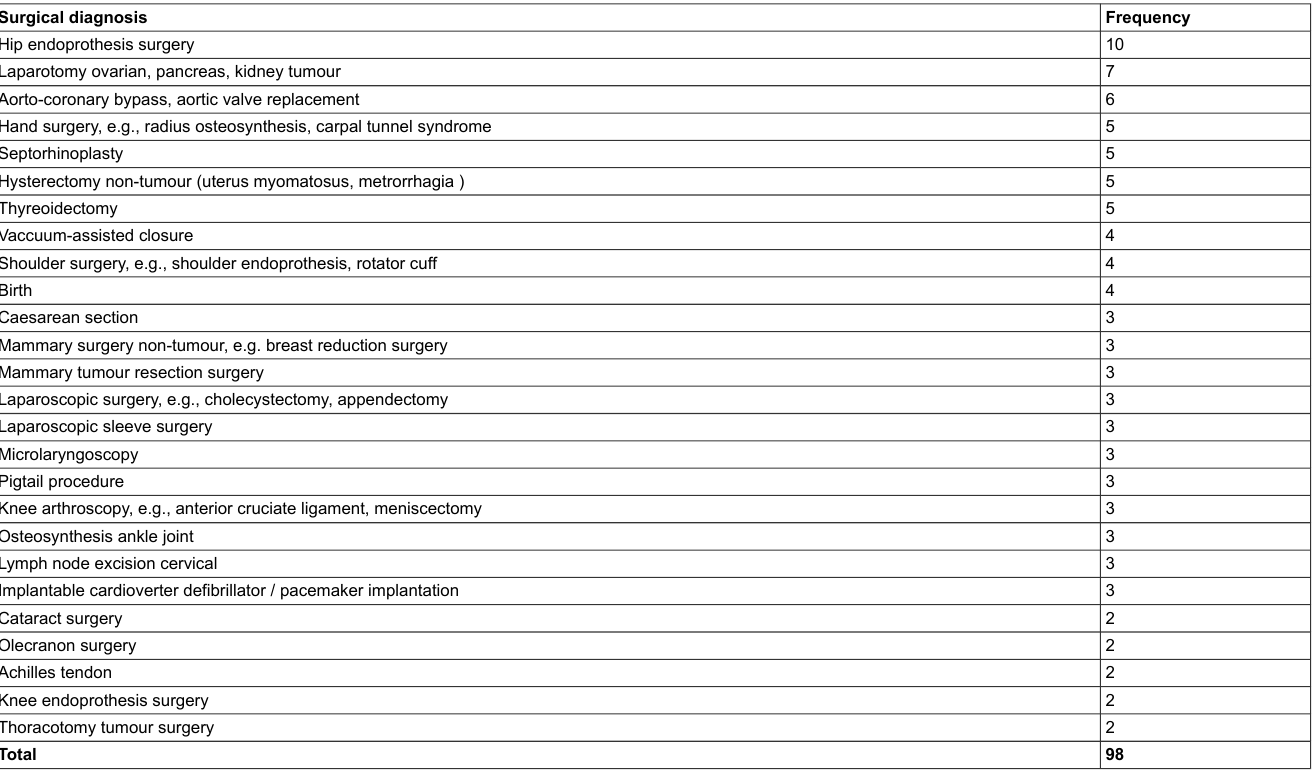
Table 1: The most common surgical diagnosis of the patients who received anaesthesia and for whom an anaesthesia-related complication occurred between 2003 and 2019, n = 98. The rest of the patients are not included in this table as their diagnosis occurred only once. Surgical diagnosis Frequency Hip endoprothesis surgery